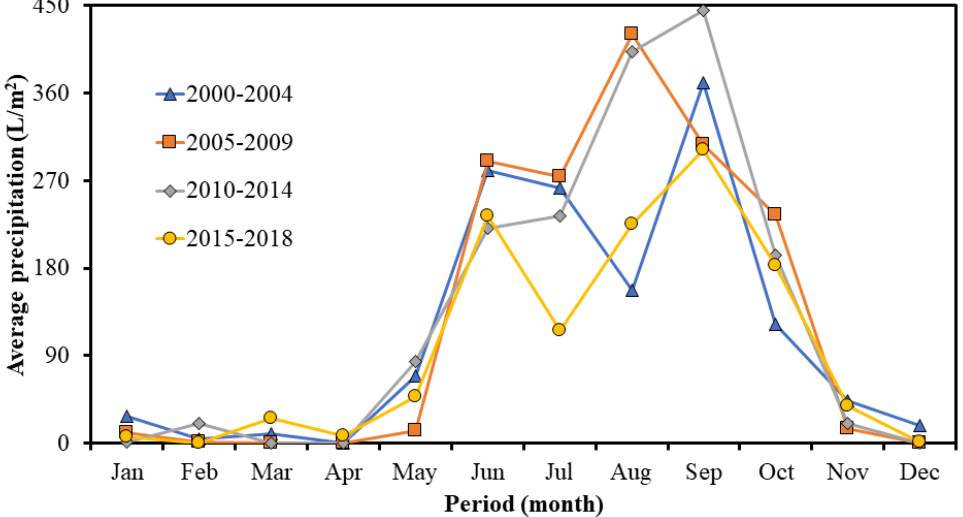
Figure 2. Historical behavior of the monthly precipitation reported by climatological station 12,142.